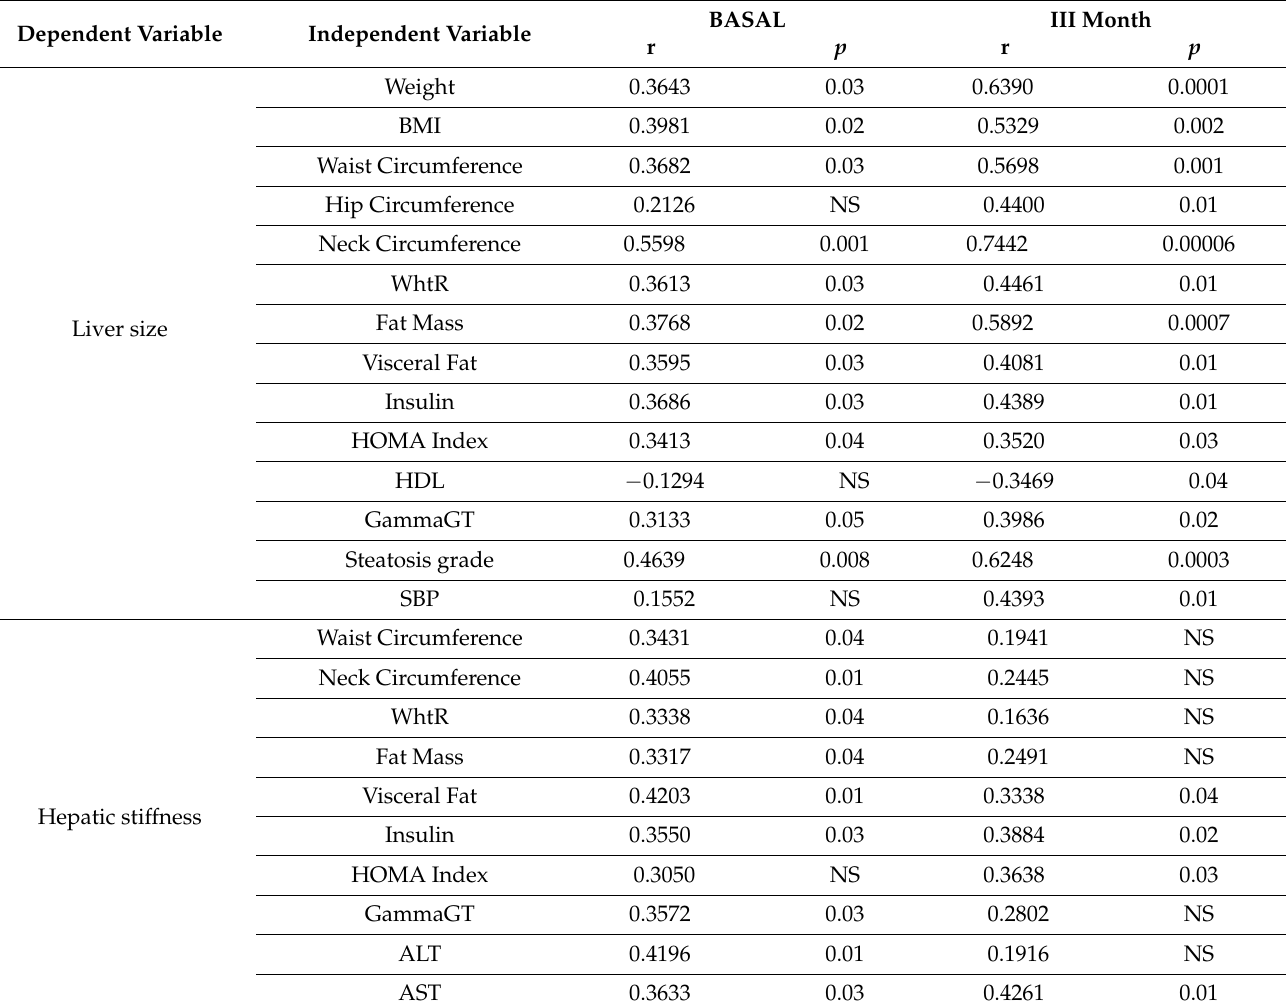
Table 4. Linear regressions between liver measurements and clinical-laboratory parameters at Basal and after 3 months of lifestyle modification (Pearson) (n. 26